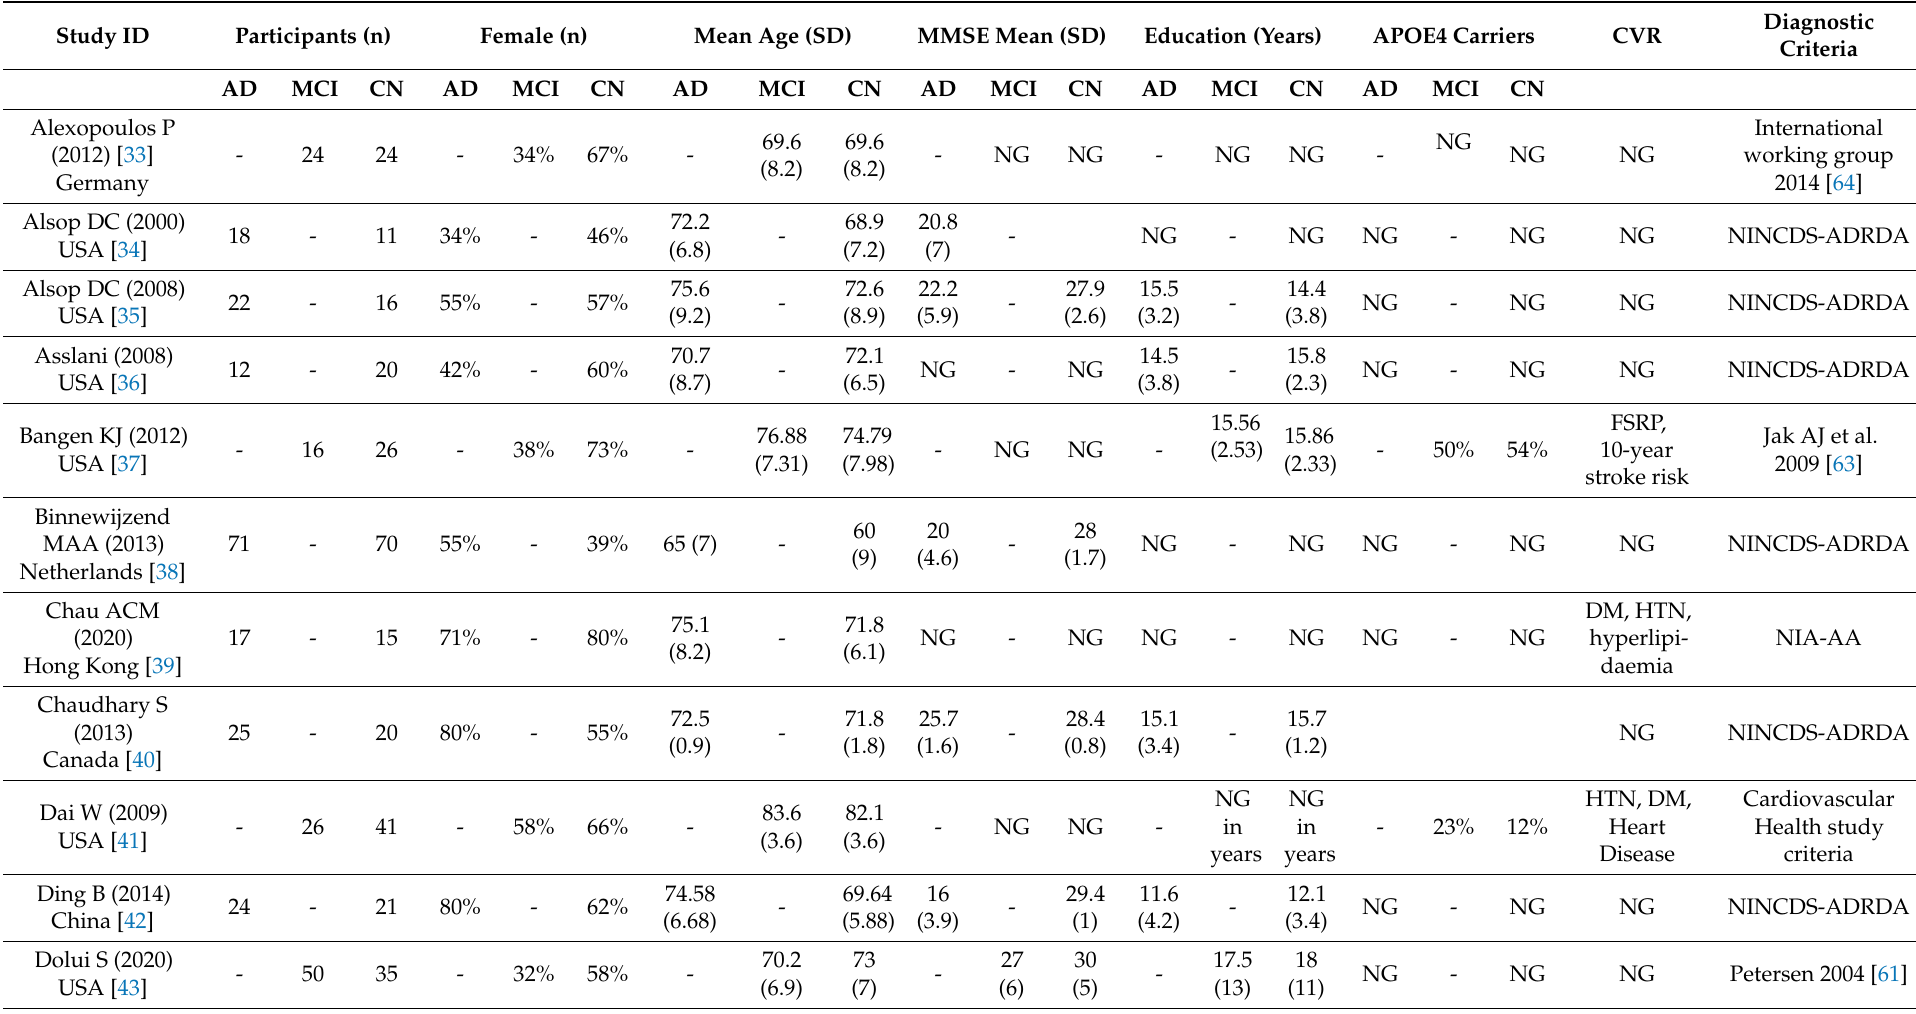
Table 1. Participant demographics and clinical